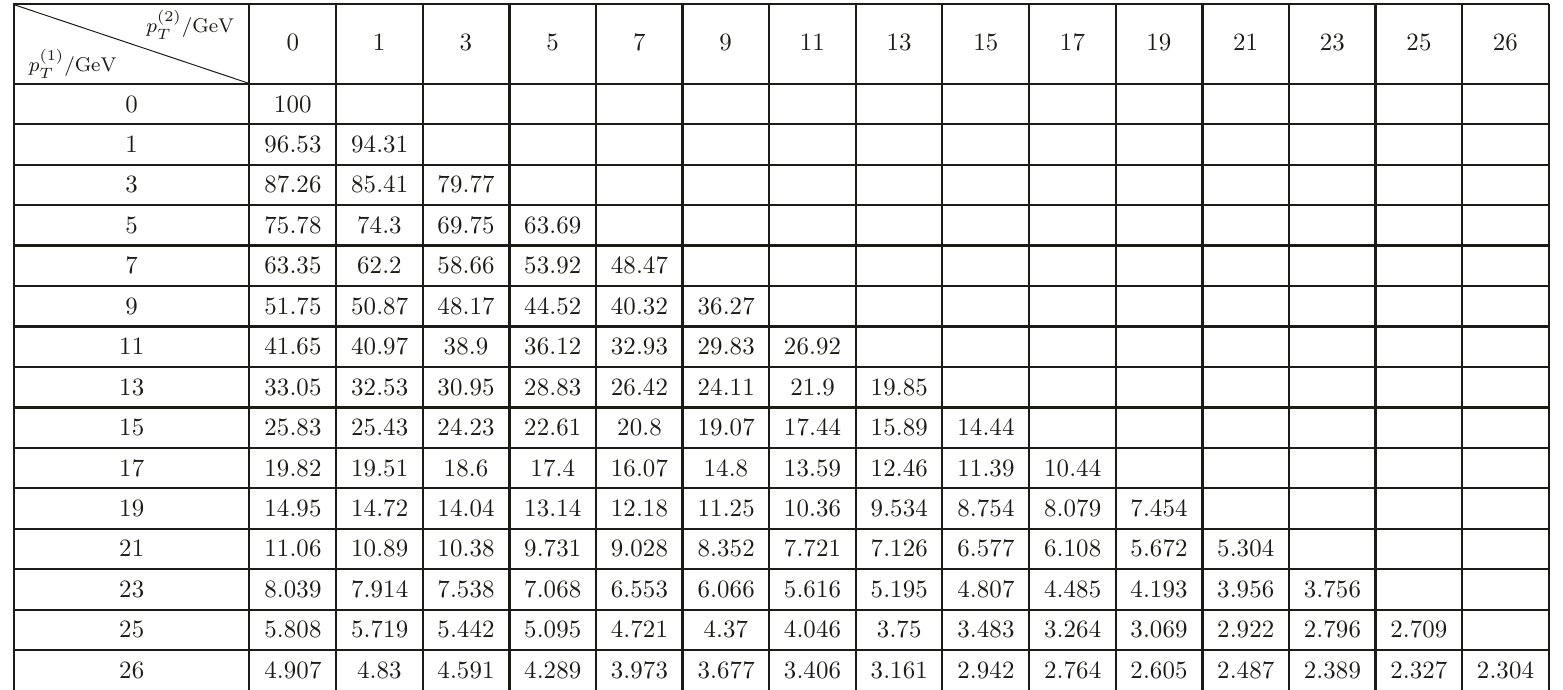
sublead. l (2) T > p T on the third lepton for BP1